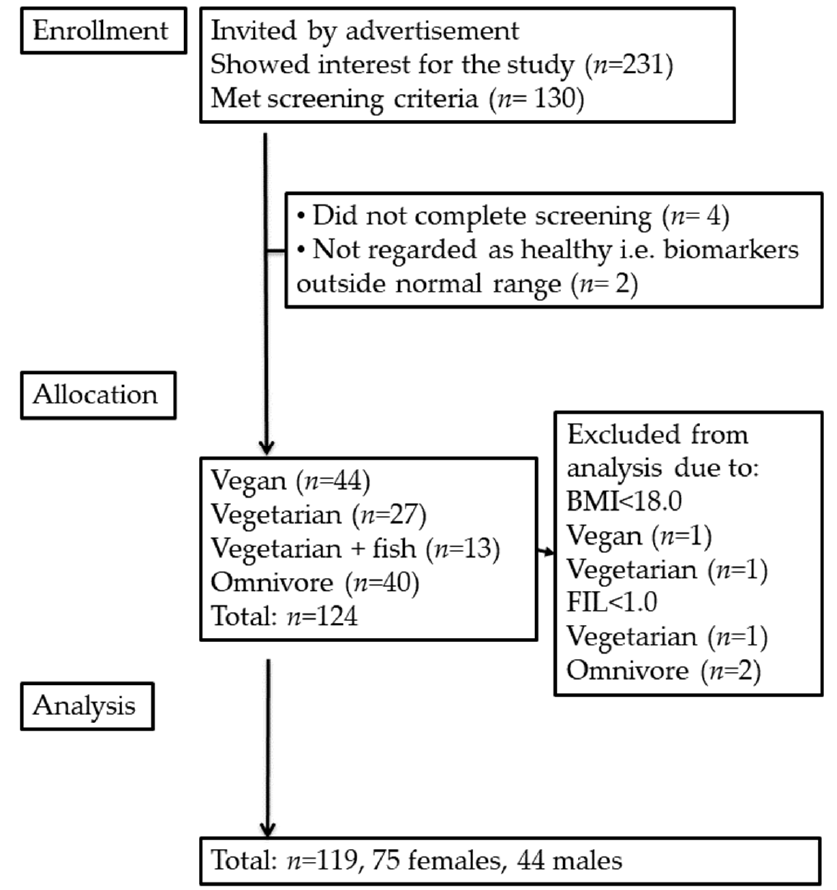
Figure 2. Study flowchart. Body mass index, BMI; food intake level, FIL.